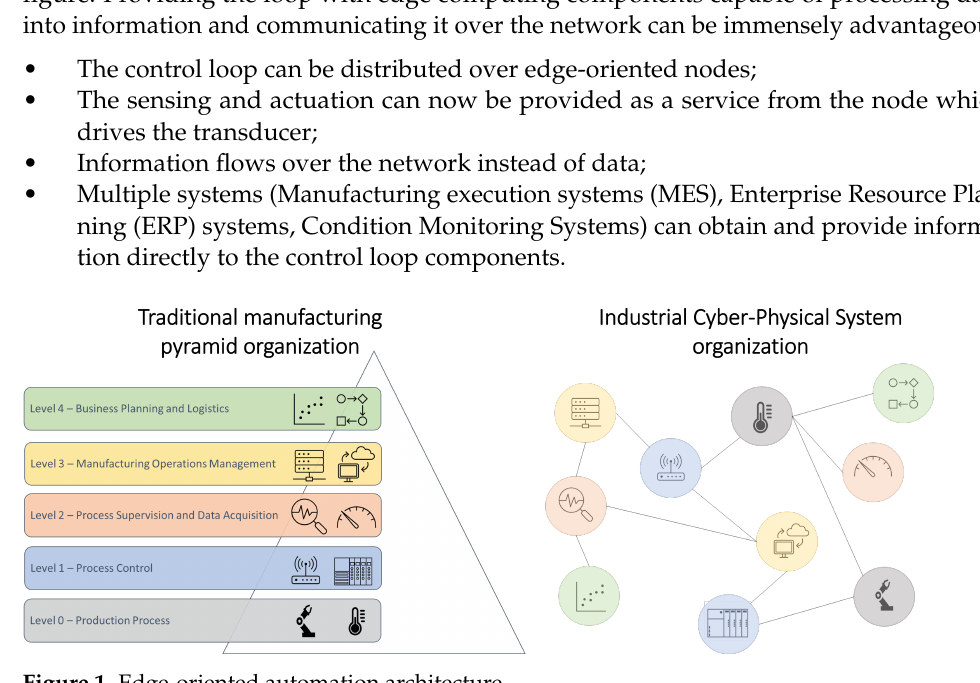
figure. Providing the loop with edge computing components capable of processing data